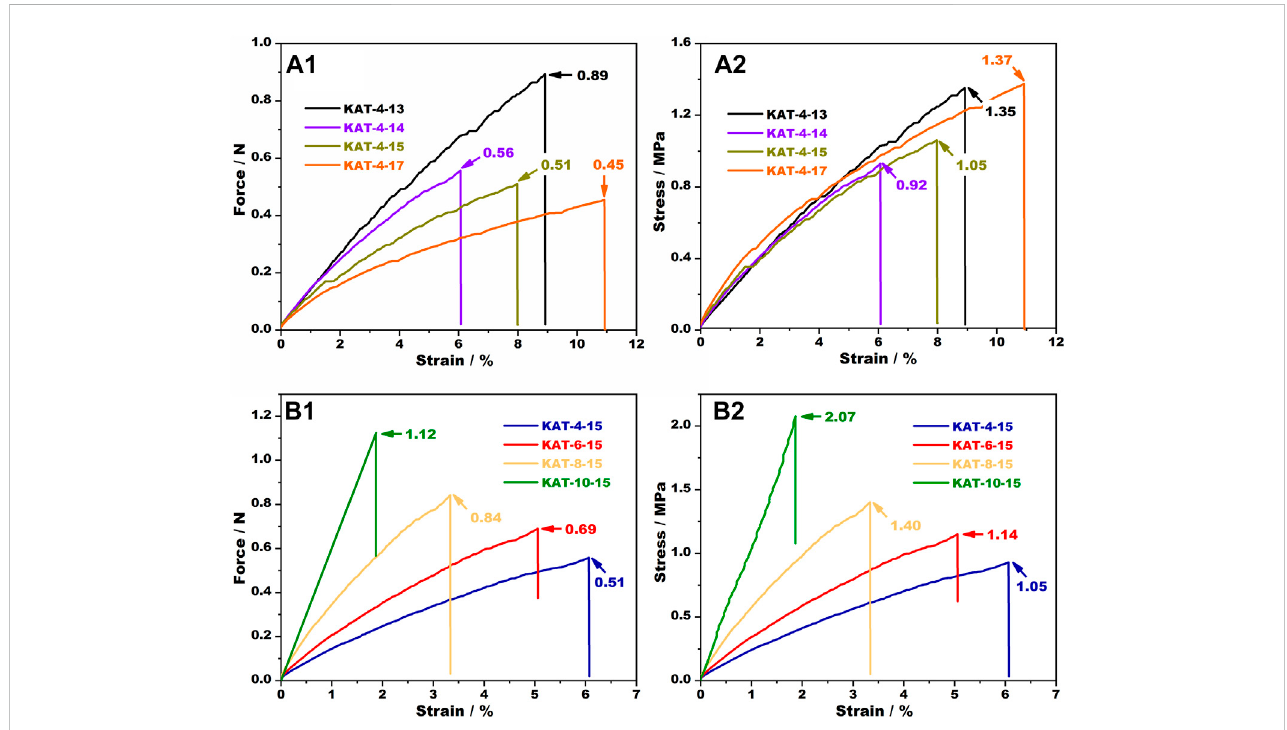
FIGURE 5 The force-strain and stress-strain curves of the resultant aerogel tapes fabricated with (A) different needles and (B) from different spinning suspensions with varying Kevlar concentrations.